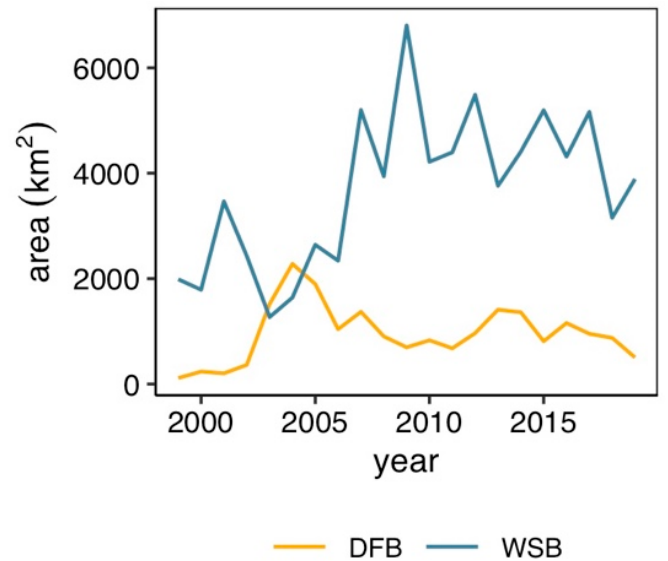
Figure 2. The annual area of Douglas-fir forest affected by Douglas-fir beetle (yellow) and western spruce budworm (blue) in the Southern Rocky Mountain ecoregion as reported in USFS ADS surveys for the Southern Rockies [25].